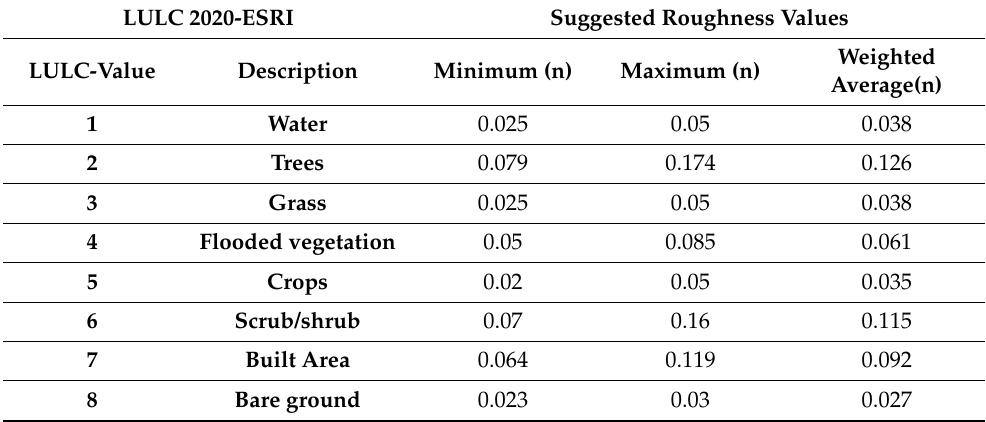
Table 10. Recommended Manning’s roughness (n) values for the global LULC 2020-ESRI